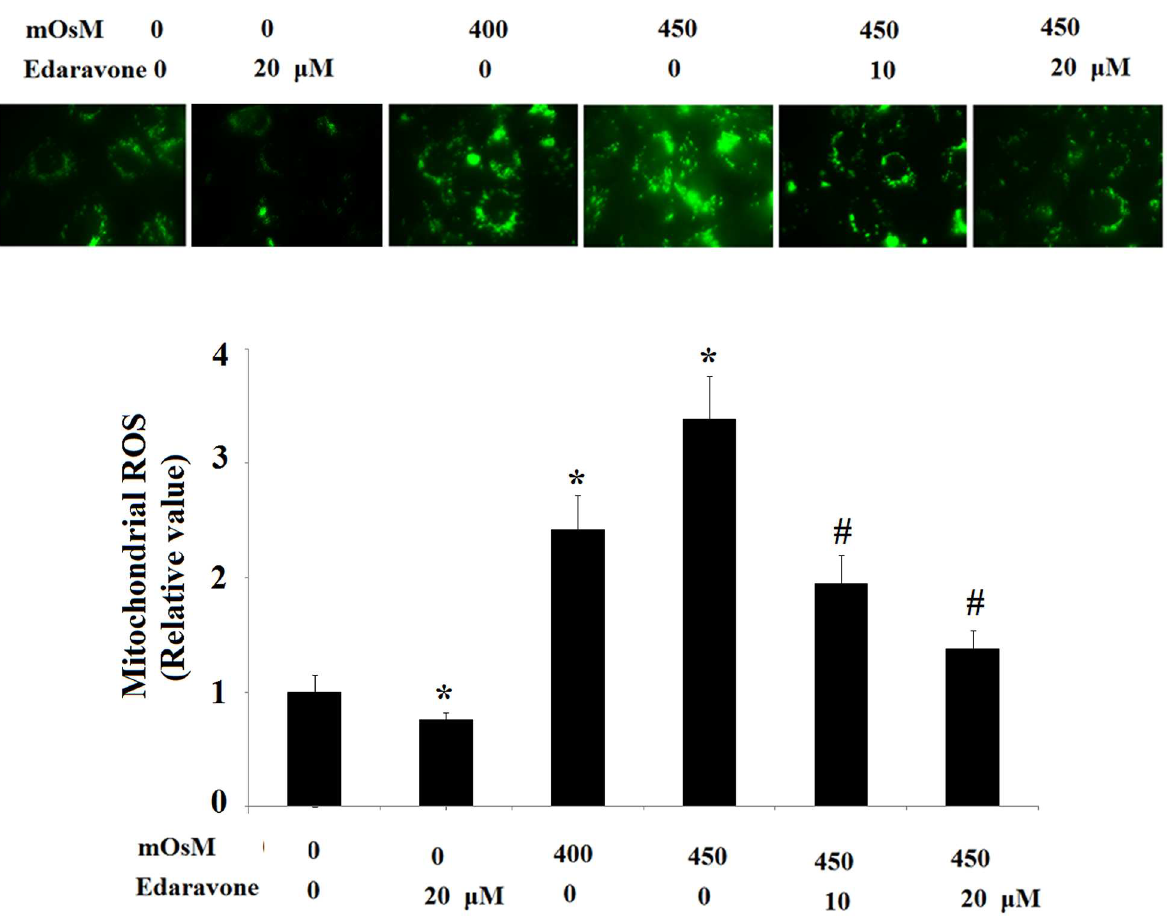
Fig 2. Suppressive effects of edaravone on mitochondrial function at 10 or 20 μ M. ROS in primary HCEpiCsexposedto hyperosmotic media (400–450mOsM), evaluatedvia MitoSox Red staining(ANOVA: * , P < 0.001vs. untreatedcontrol; #, P < 0.001vs. 450 mOsM treated